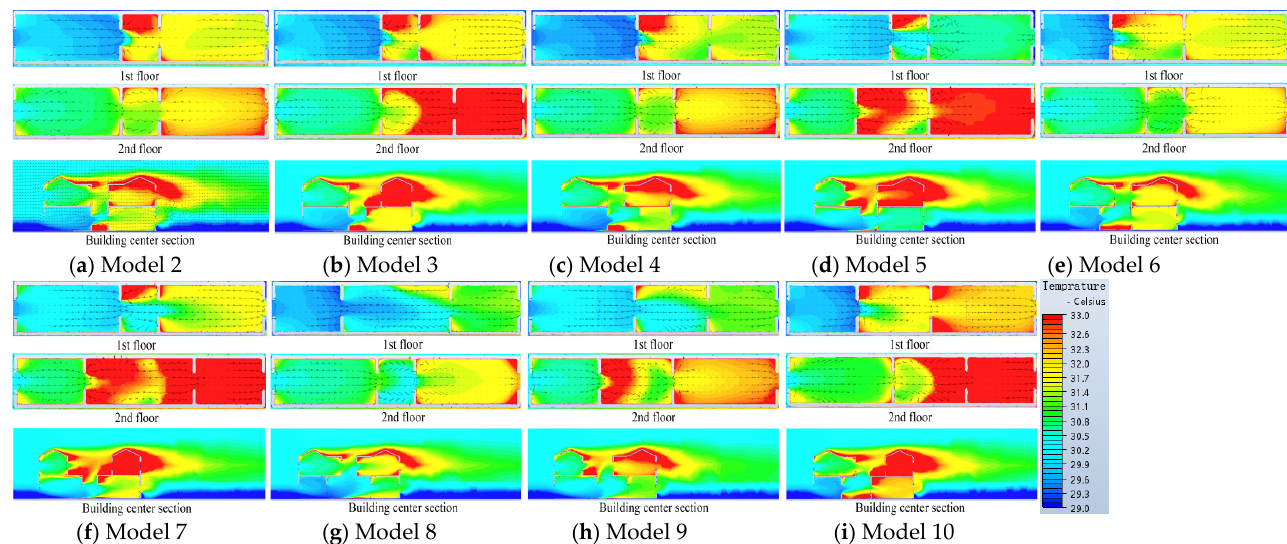
Figure 10. Simulated spatial distributions of T a in Models 2–10 at 12:00 at 1.2 m height on each floor.